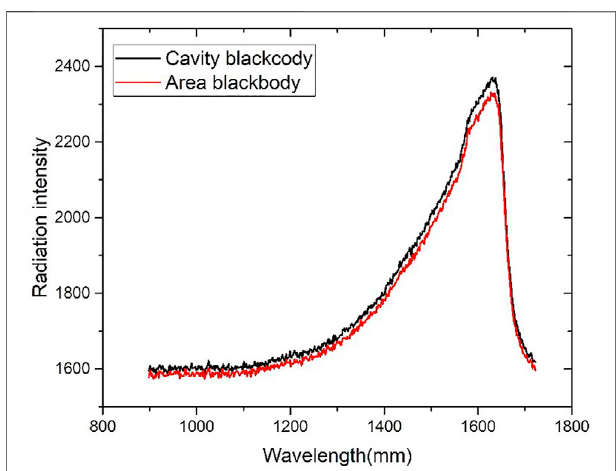
FIGURE 8 | Experiment results at 420 ° C (cavity blackbody and area blackbody radiation intensity with wavelength).